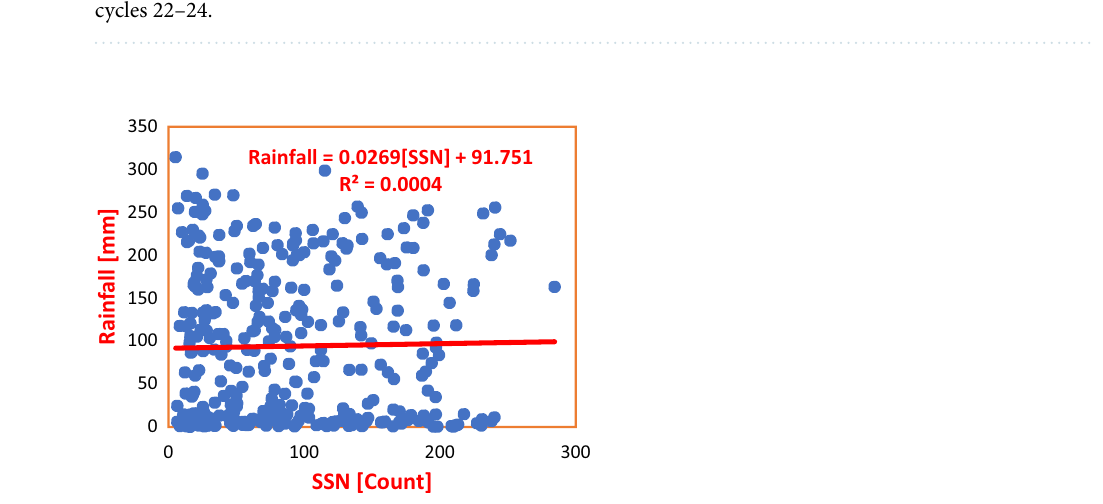
Table 3. Regression equations for SSN regressed on SAT and rainfall in Nigeria and Cote D’Ivoire during solar cycles 22–24.